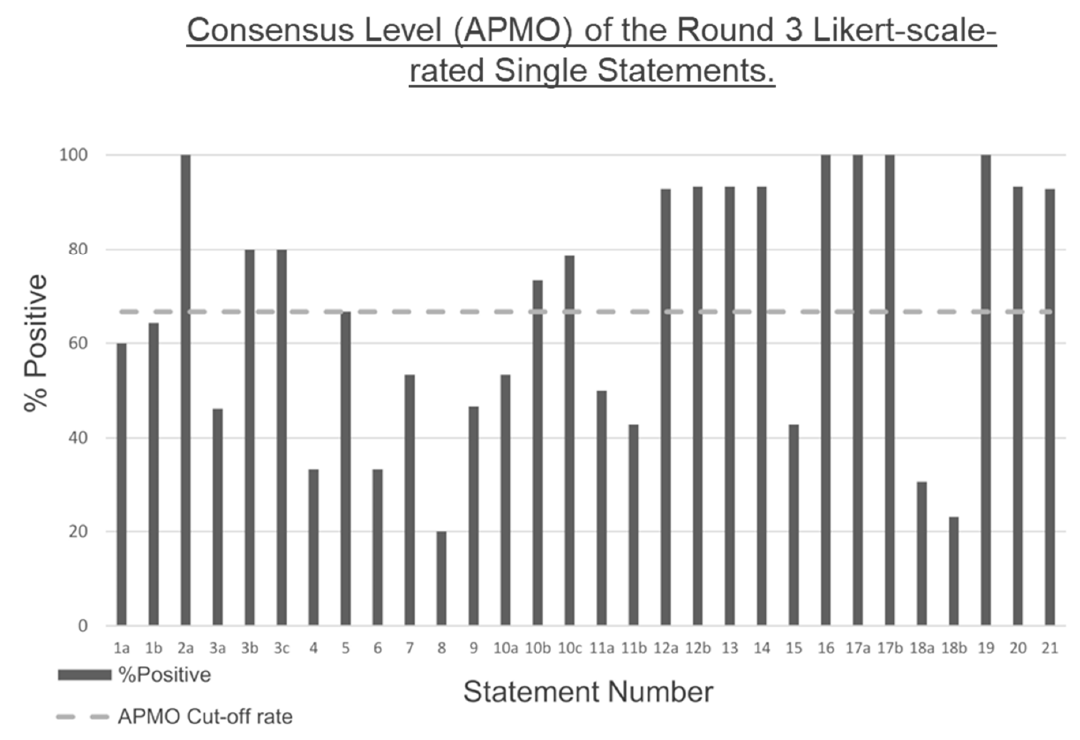
Figure 5. The Likert-scale-rated single statements with an APMO above that of the APMO cut-off rate in round 3 (66.67%; dashed line). Table 2. A summary of the Likert-scale-rated single statements that reached consensus in round 2 (APMO 80.43%, IQR ≤ 1). Table 4. A summary of the Likert-scale-rated single statements that can be used as guidelines by which to assess the structural quality of repair cartilage, those factors that could influence a successful cartilage repair and those that consider Round 2 Statement the economic and ethical implications of cartilage repair.